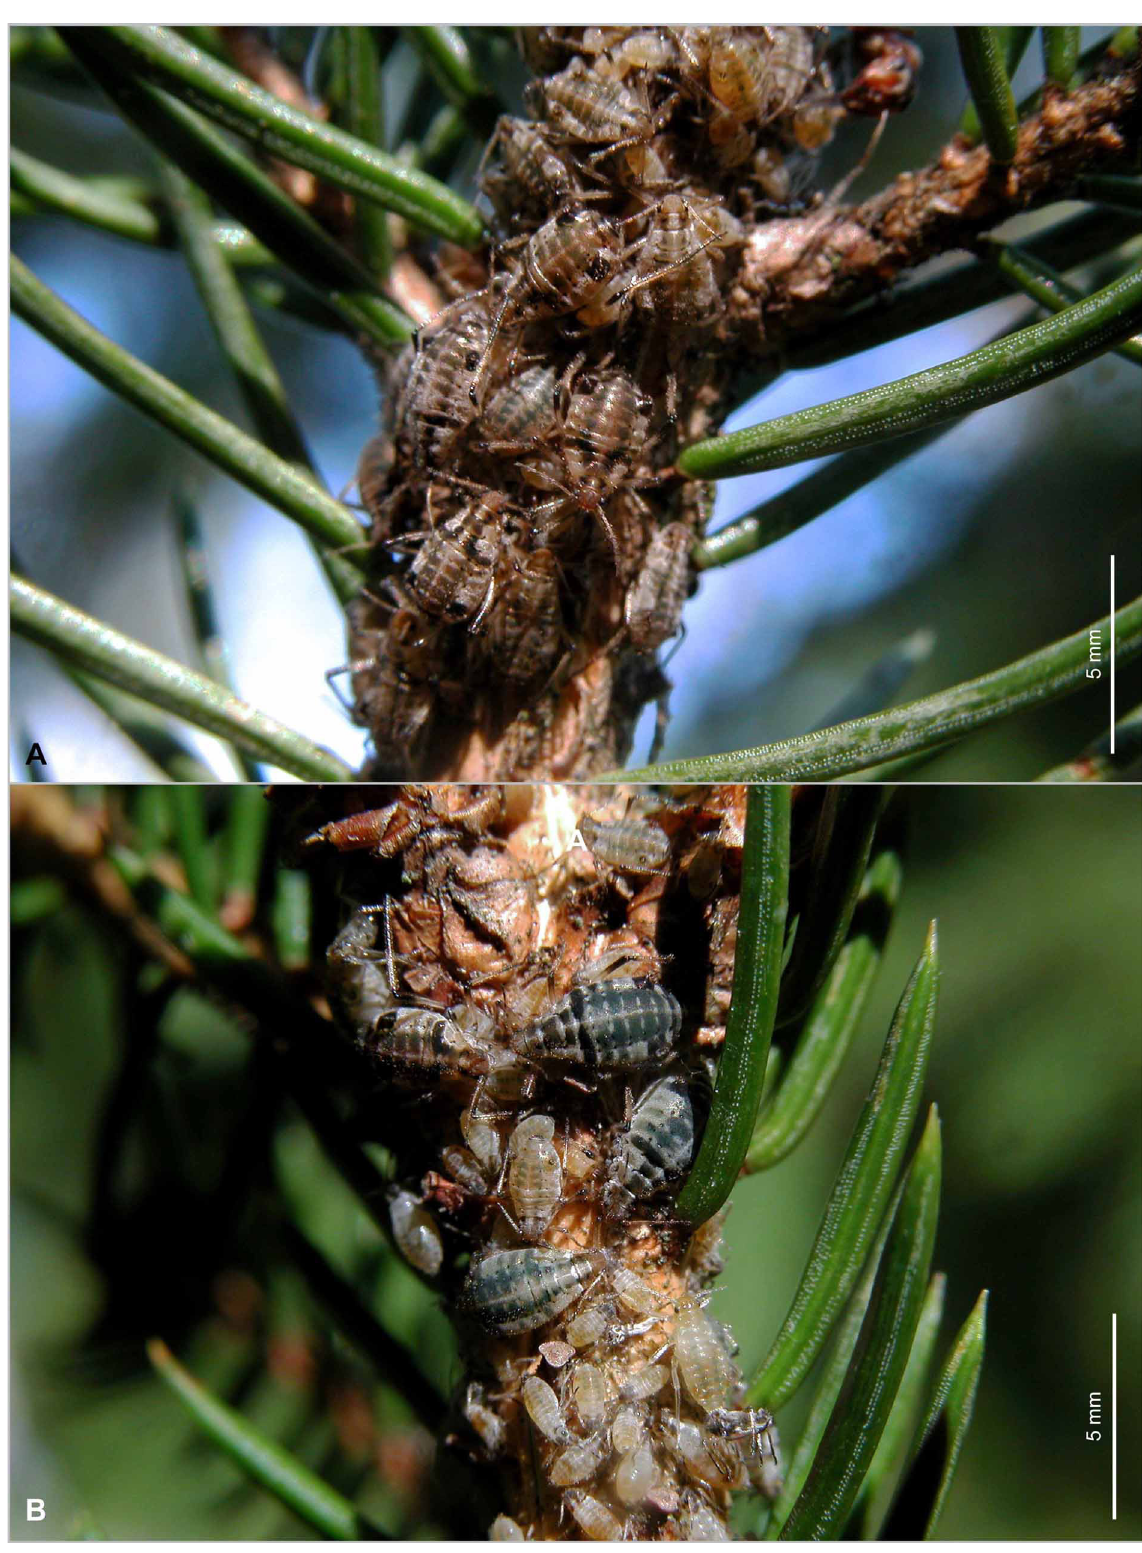
Fig. 34. Cinara (Cinara) pruinosa (Hartig, 1841). Colony on underside of branch of Picea abies , attended by Formica aquilonia Yarrow, 1955. Adult and juvenile